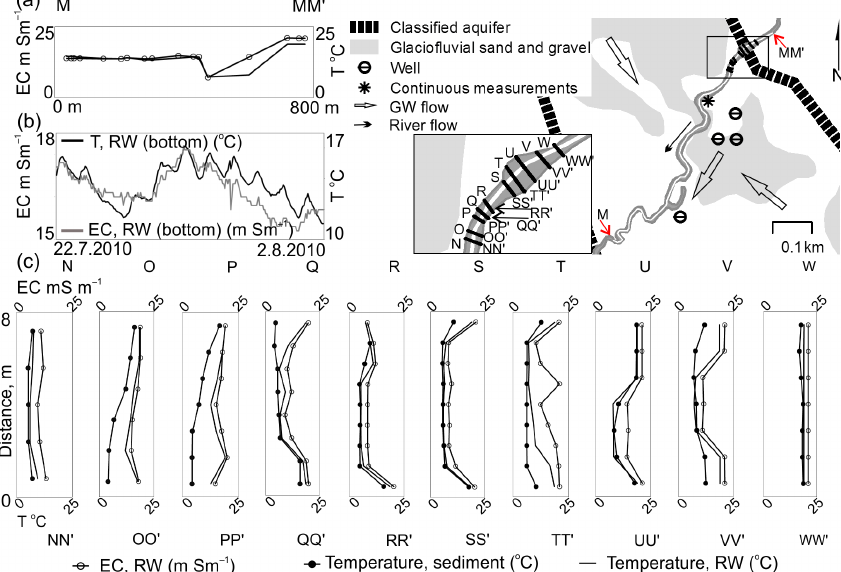
Figure 7. Field studies at the River Palojoki study site during the low-flow period in July 2010: (a) longitudinal profile of RW temperatures (M–MM (cid:48) ) near the sediment–water interface; (b) continuous measurements of temperature and EC in RW 0.2m above the river bottom (monitoring period from 22 July to 2 August 2010) and (c) cross-sectional profiles (from N–NN (cid:48) to W–WW (cid:48) ) of temperature and EC in RW near the sediment-water interface and temperature in the sediment (water depth ranging from 0.10 to 1.62m). (Basemap Database © National Land Survey of Finland 2010; Quaternary Deposit Database © Geological Survey Finland 2008; Groundwater Database © SYKE 2010.)